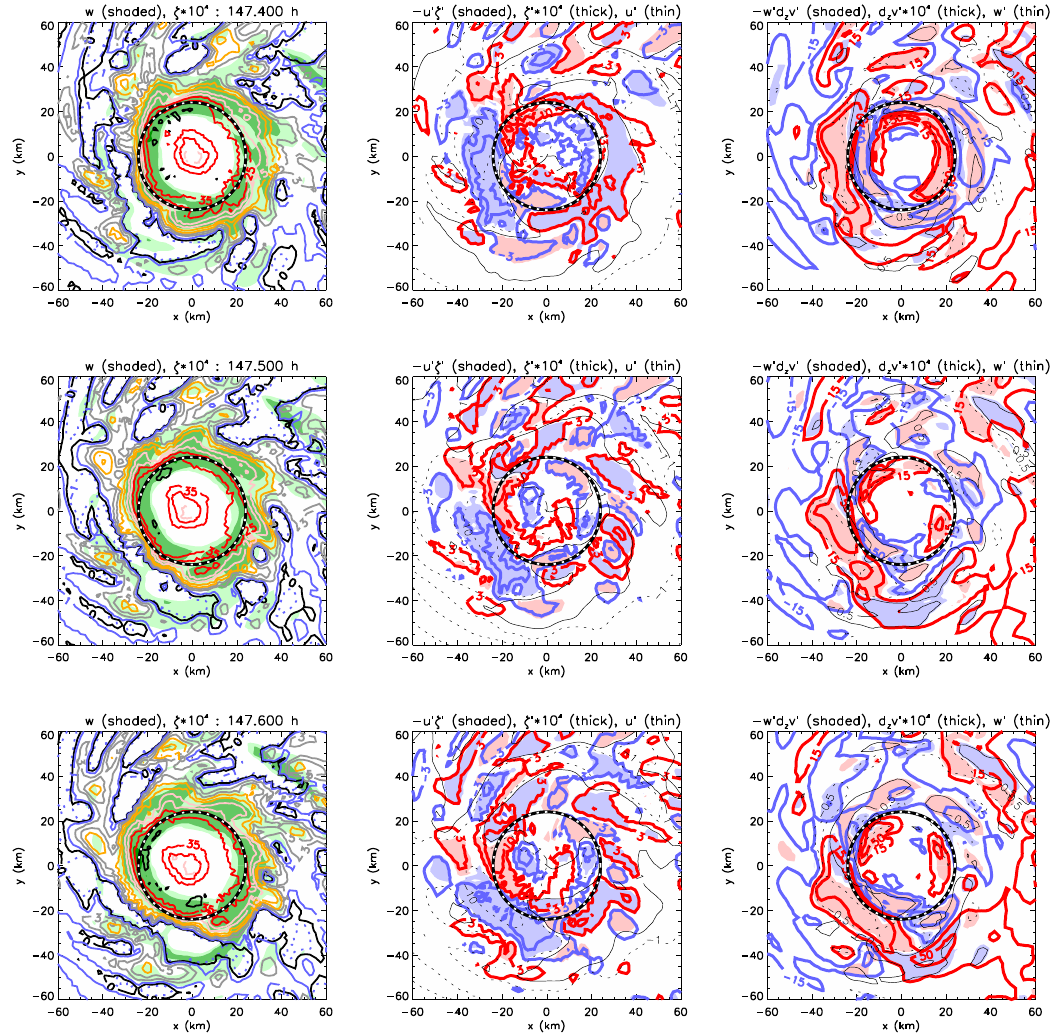
Fig. 20. (Left) Vertical velocity w (shaded; levels 0.3, 1.0, 3.0 m s − 1 ) and relative vertical vorticity ζ times 10 4 (levels (s − 1 ): -1 blue dotted, 0 black, 1 blue, 3 and 5 gray, 7 and 10 orange, 15 and 20 pink, 25 and 35 red, 50 and 75 black) at a sequence of times at z = 1 . 5 km from the 3D3k simulation. (Center) Radial eddy contributions (shaded (m s − 1 h − 1 ): blue − u ′ ζ ′ < − 3 ; pink − u ′ ζ ′ > 3 ) to the azimuthally-averaged tangential wind tendency ∂ h v i /∂t at the same sequence of times at z = 1 . 5 km from the 3D3k simulation. The eddy vertical vorticity ζ ′ × 10 4 (thick blue contours -30, -10, -3 s − 1 ; thick red contours 3, 10, 30 s − 1 ) and eddy radial velocity u ′ (dashed negative contours: -10, -1 m s − 1 ; thin black contours: 1, 10 m s − 1 ) are superposed. (Right) Vertical eddy contributions (shaded (m s − 1 h − 1 ): blue − w ′ ∂v ′ /∂z < − 3 ; pink − w ′ ∂v ′ /∂z > 3 ) to ∂ h v i /∂t at the same sequence of times at z = 1 . 5 km from the 3D3k simulation. The vertical derivative of eddy tangential wind ∂v ′ /∂z × 10 4 (thick blue contours -15, -5, -1.5 s − 1 ; thick red contours 1.5, 5, 15 s − 1 ) and eddy vertical velocity w ′ (dashed negative contours -0.5, -5 m s − 1 ; thin black contours 0.5, 5 m s − 1 ). For reference, a spotted-black curve highlights the r = 24 km radius, the approximate low-level RMW during this analysis interval.